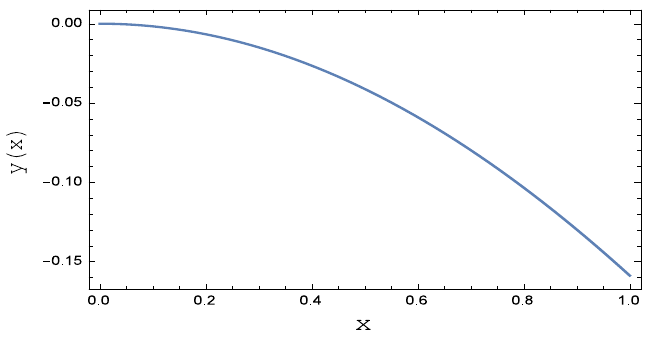
Figure 7. Graph of approximate solution of the Example 4 with m=10 iterations and N =